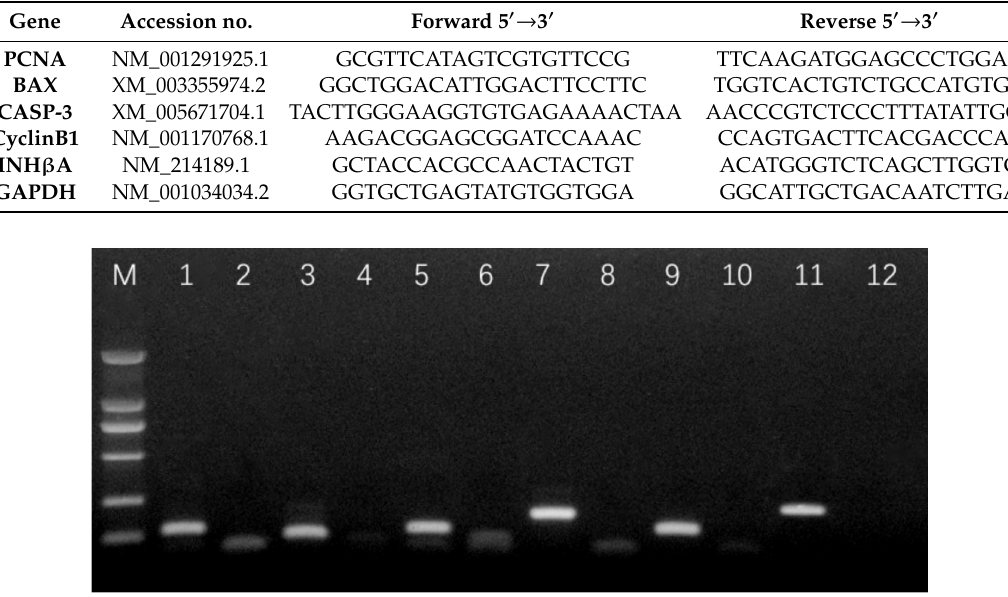
Figure 1. Amplification of six genes by gel electrophoresis. M: DL2000; 1: GAPDH; 2: